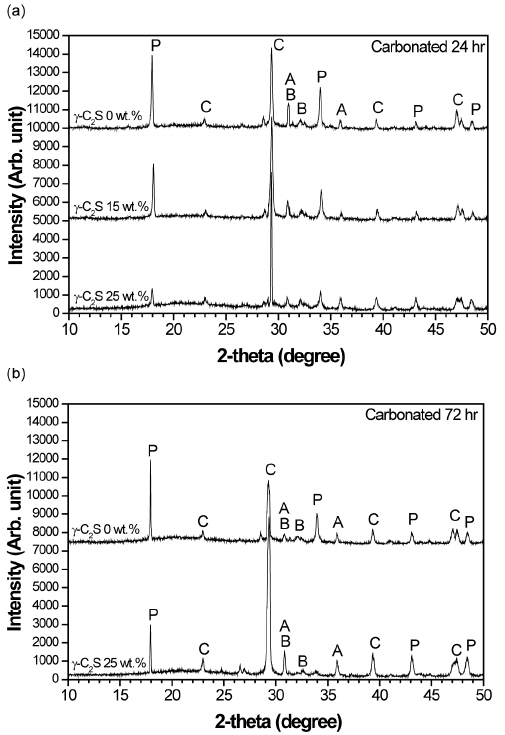
Figure 4. XRD results on the carbonated (colorless) outer regions of the blocks ( a ) at 24 h and ( b ) 72 h. P = portlandite (Ca(OH) 2 ); C = calcite (CaCO 3 ); B = belite (C 2 S); A = alite (C 3